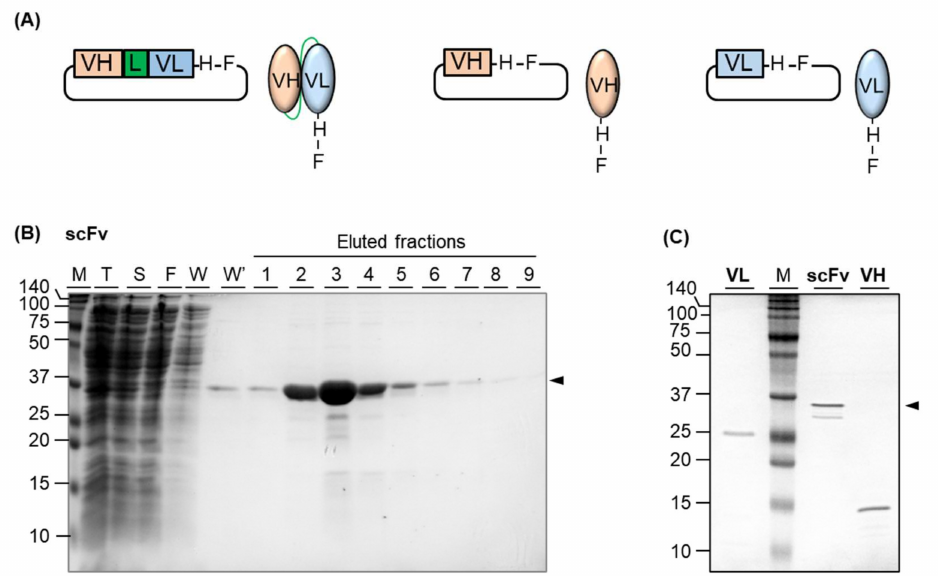
Figure 2. ( A ) Schematic representation of DNA plasmids and antibody fragments. L, H, and F indicates GS linker, His-tag, and Flag-tag, respectively. ( B ) Fractions at the purification step of anti-PD-L1 scFv. M, T, S, F, W, W’, and numbers indicates marker, total reagent after sonication, supernatant after centrifugation of sonicated protein, flow through fraction, washing fraction using a buffer including no imidazole, washing fraction using a buffer including 20 mM imidazole, and the order of eluted fractions using a buffer including 250 mM imidazole, respectively. ( C ) SDS-PAGE analysis of purified scFv, VH, and VL after buffer changing using an